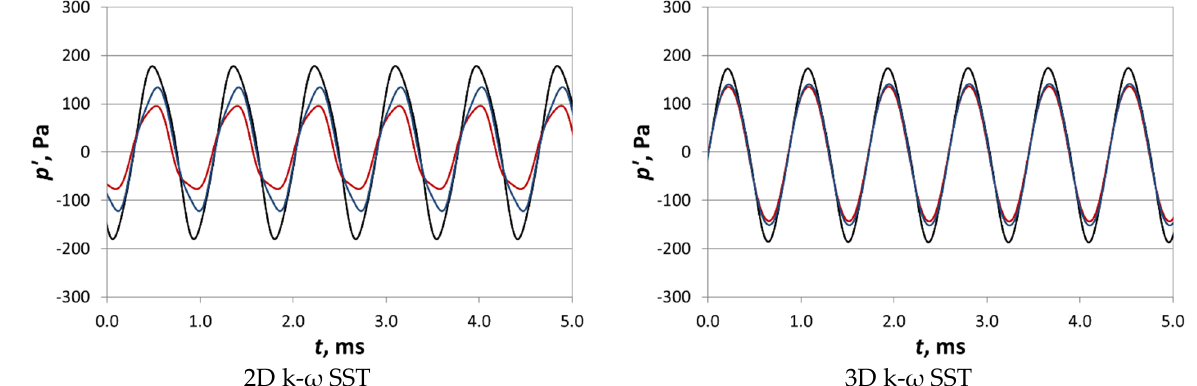
Figure 11. Acoustic pressure fluctuations for velocity in the main channel equal to 50 m/s—CFD.